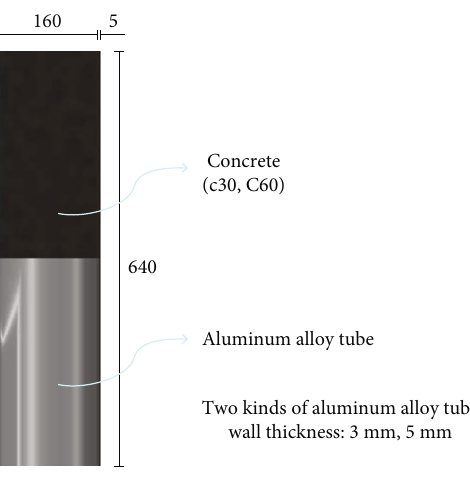
Figure 1: Specimen parameter diagram. Table 1: Basic parameter table of specimen design.